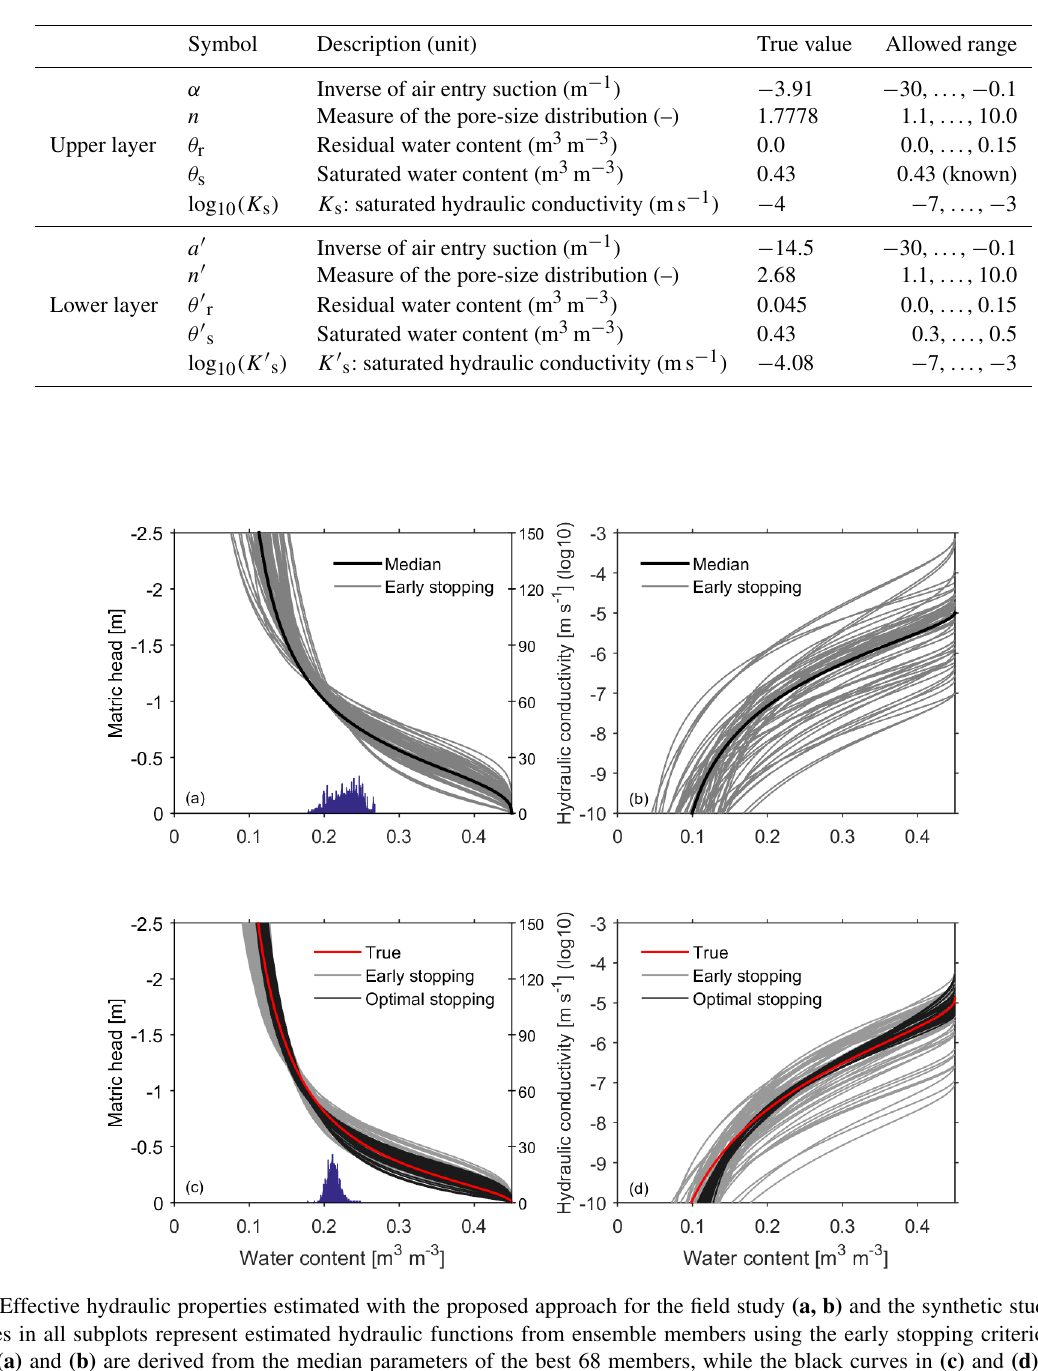
Table 2. Hydraulic parameters of the two-layer soil and their allowed ranges for parameter estimation. The true values for the upper layer are obtained from Rosetta (Schaap et al., 2001) based on measured soil texture information, and the values for the lower layer are cited from Carsel and Parrish (1988).